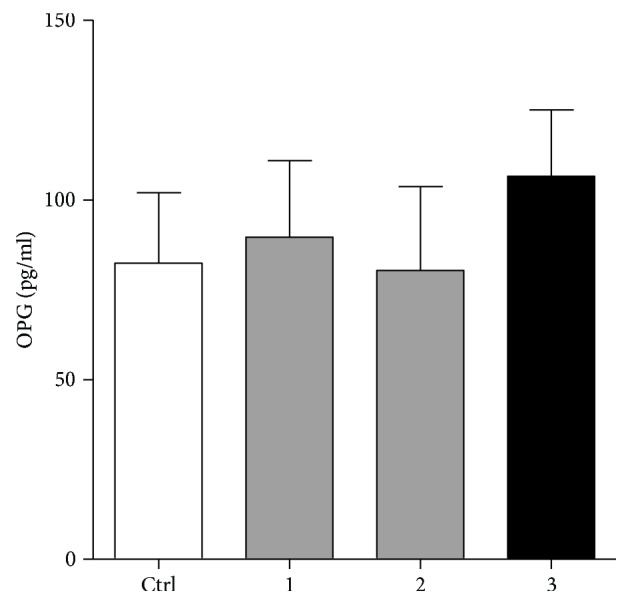
Modulation of OPG production in PL cell cultures by RANKL or anti-RANKL neutralizing antibody. Periapical lesion (PL) cells were isolated from 12 PLs and cultivated for 24 hours with 10 ng/ml (labeled as 1 on x axis), 30 ng/ml (labeled as 2) of RANKL, or anti-RANKL neutralizing antibody (2 μg/ml) (labeled as 3) as described in “Materials and Methods.” The levels of OPG in supernatants were measured by ELISA, and after that, the RANKL/OPG ratio was calculated. All differences in relation to control (Ctrl) were not statistically significant (p > 0.05).